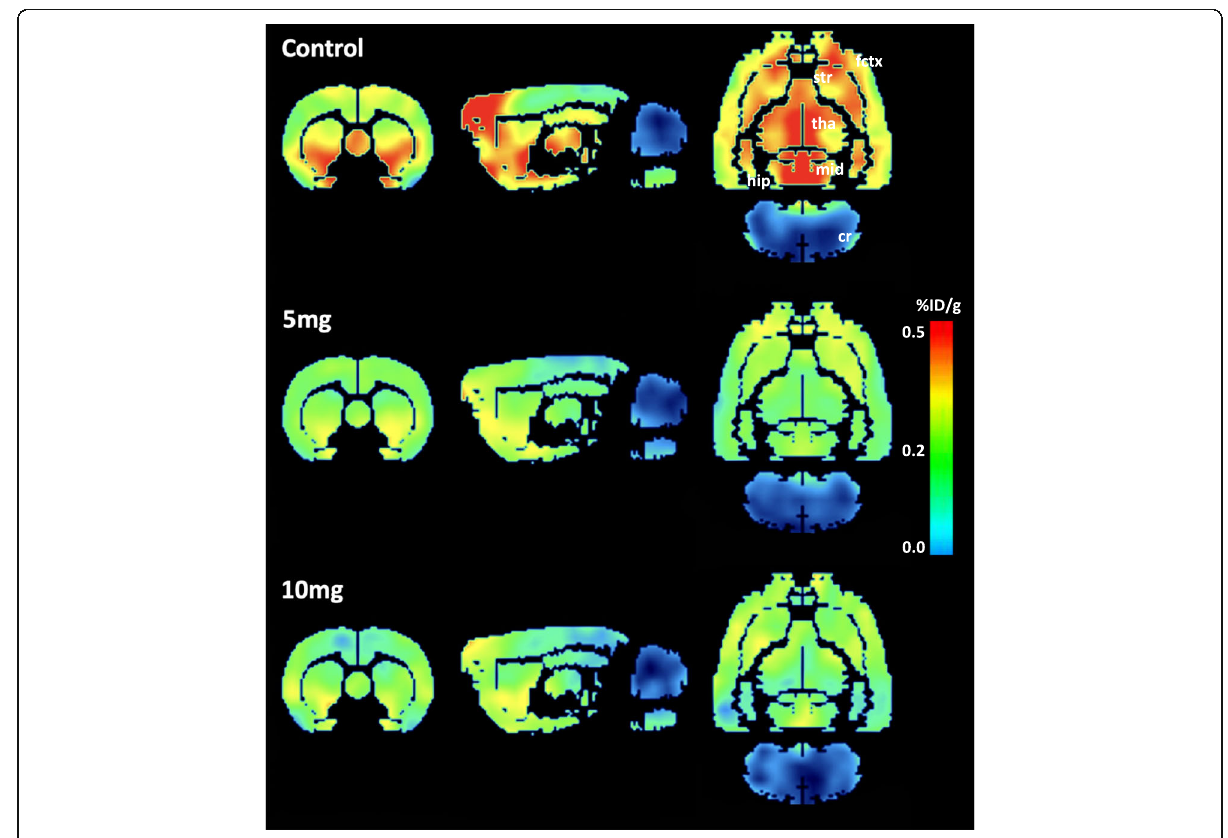
Fig. 1 An example of 2D images showing 4-[ 18 F]ADAM distribution obtained 60 – 90 min after administration of 4-[ 18 F]ADAM in control animals (upper panel) and those treated with 5 mg/kg of METH (middle panel) and 10 mg/kg of METH (lower panel). Higher 4-[ 18 F]ADAM accumulations were found in the amygdala, caudate/putamen, midbrain, and hippocampus. Lower accumulation of radioactivity was found in the cerebellum. The accumulation of 4-[ 18 F]ADAM illustrates decreased SERT availability in the METH-induced groups. The accumulated radioactivity was expressed as a percentage of the injection dose/tissue gram (%ID/g). fctx, frontal cortex; str, striatum (caudate/putamen); tha, thalamus; mid, midbrain; hip, hippocampus; cr,